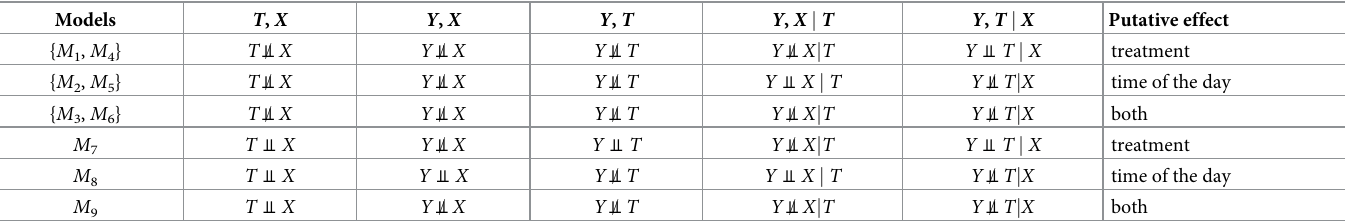
Table 1. Subset of the conditional independence relations, spanned by the causal models in Fig 2, that are sufficient to distinguish between the 6 equivalence classes of models: { M 1 , M 4 }, { M 2 , M 5 }, { M 3 , M 6 }, M 7 , M 8 , and M 9 . Models T , X Y , X Y , X j T Y , T j X Putative